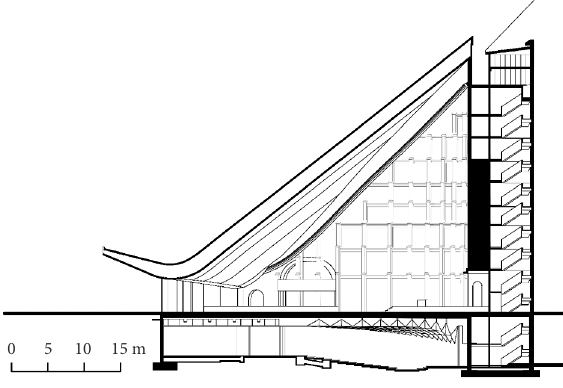
Figure 4. Section of the church